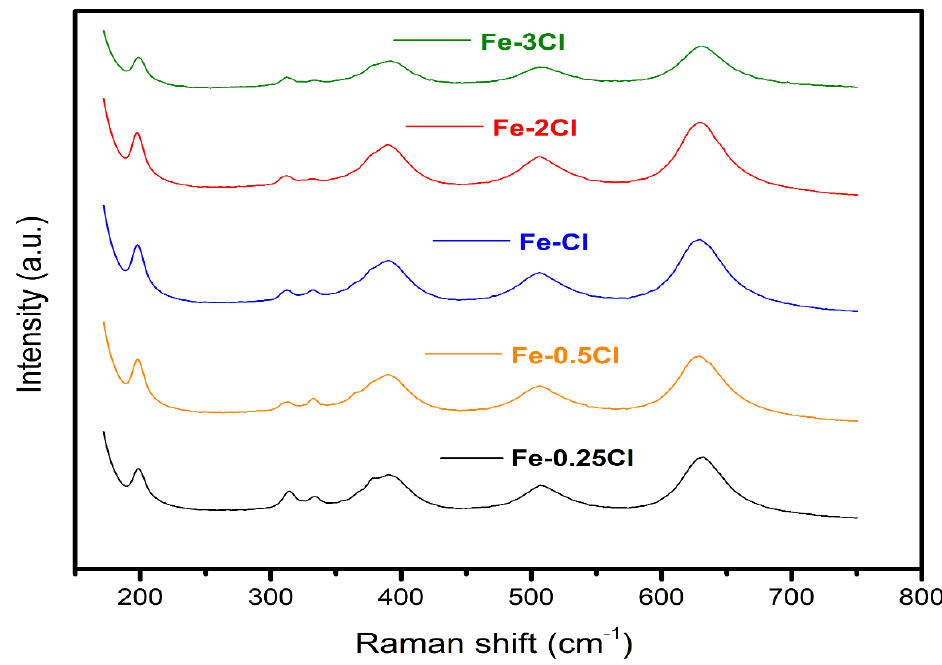
Figure 7. Raman spectra for FeS–0.25Cl, FeS–0.5Cl, FeS–1.0Cl, FeS–2.0Cl and FeS–3.0Cl catalysts.